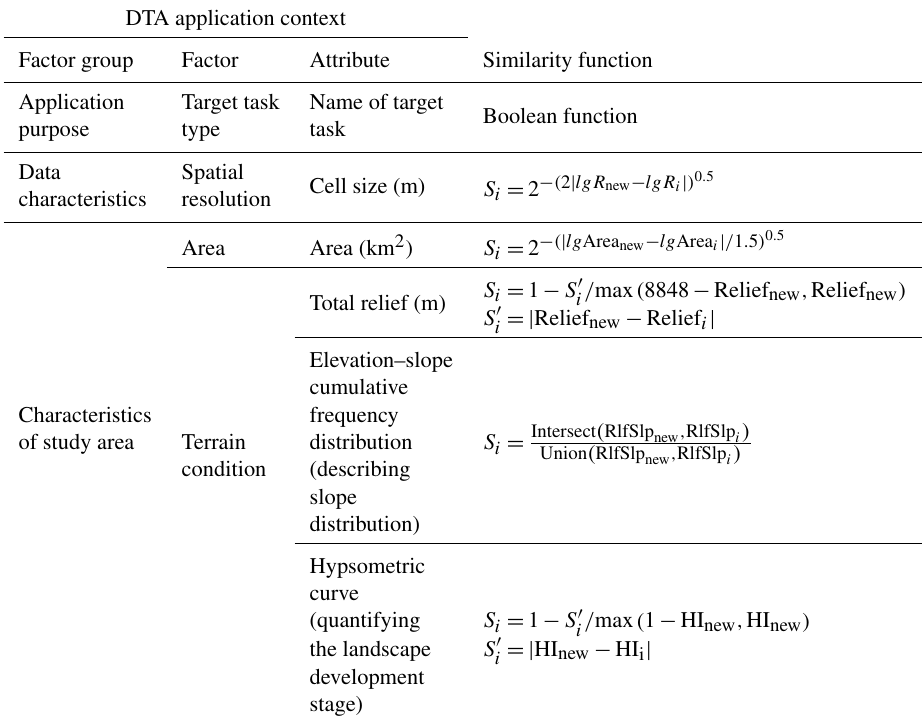
Table 2. Attributes used in this study to formalize the case problem and the corresponding similarity functions for case-based reasoning using DTA application-context